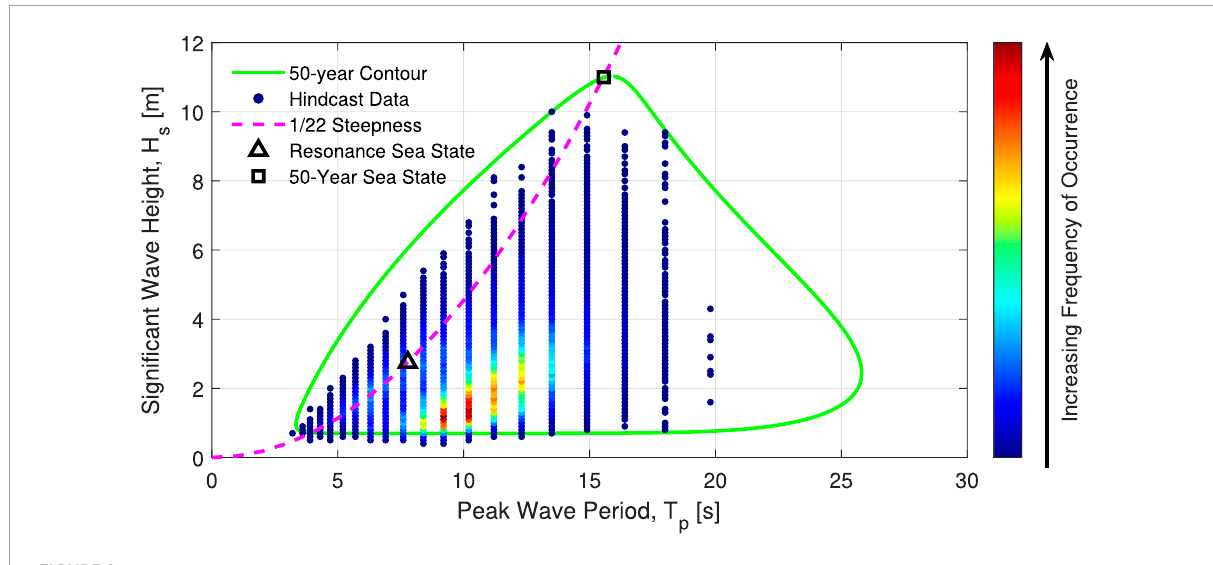
FIGURE 2 Environmental conditions for the EMEC site. The 50-year contour (green solid line), 1/22 steepness contour (magenta dashed line) and the two sea states considered in this study are presented: 50-year sea state (black square); Resonance sea state (black